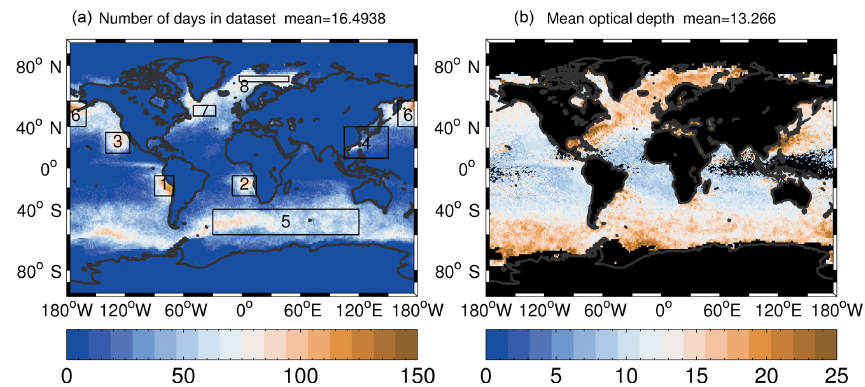
Figure 3. (a) Number of days in 2008 that fulfilled the criteria required to be counted as a valid N d retrieval. See the text for details on the criteria. Various regions of interest are also denoted by the boxes and numbers. (b) Mean optical depth for data set with filtering criteria 1–7 applied (see